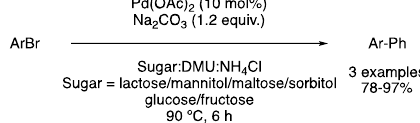
Figure 16. First example of a cross-coupling reaction in DESs.